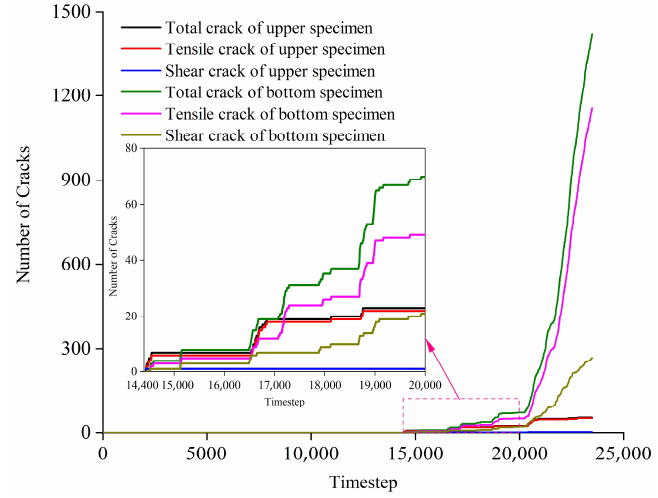
( l ) Figure 12. Evolution of contact-force chain serial coal pillar specimens. ( a ) 0; ( b ) 15,000; ( c ) 18,000; ( d ) 20,400; ( e ) 20,800; ( f ) 21,200; ( g ) 21,600; ( h ) 22,000; ( i ) 22,400; ( j ) 22,800; ( k ) 23,200; ( l ) 23,487. Note: The denoted le(cid:308)ers shown in the figure was corresponding to those on the stress-time curve in Fig- ure 11. 4.3. Crack Evolution From a qualitative and quantitative perspective, the crack number, form, and location